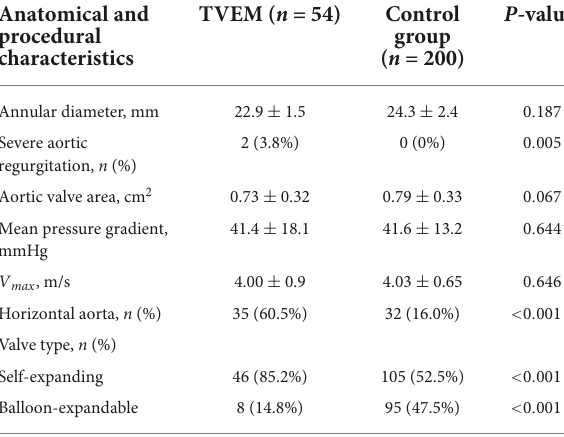
TABLE 3 Anatomical characteristics and procedural data in patients with transcatheter valve embolization and migration (TVEM) compared to the control group.